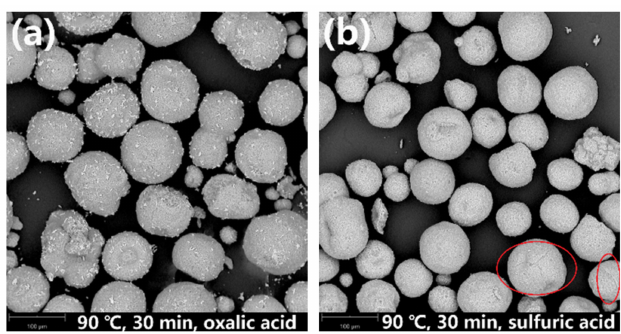
Figure 7. SEM images of leaching residues obtained after leaching at 90 ◦ C for 30 min in ( a ) oxalic acid and ( b ) sulfuric acid.